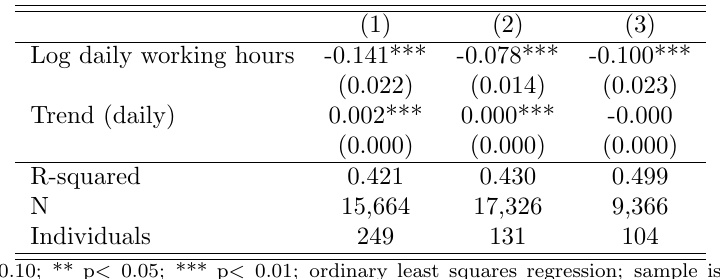
Table 8: Tenure, attrition, and the relationship between productivity and working time at the day